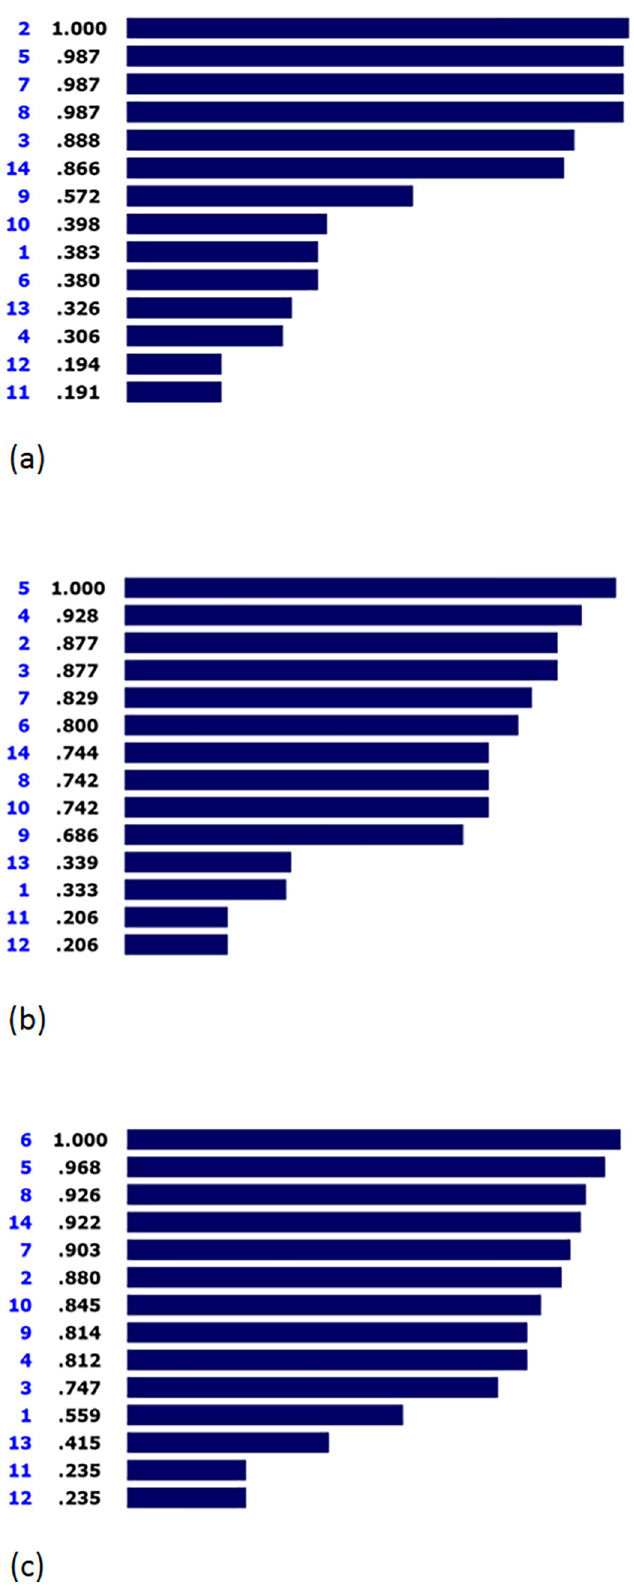
Fig 4. Prioritization of solutions based on Feasibility (a), Burden of disease (b), and Fairness (c). https://doi.org/10.1371/journal.pone.0253001.g004 PLOS ONE | https://doi.org/10.1371/journal.pone.0253001 June 8,